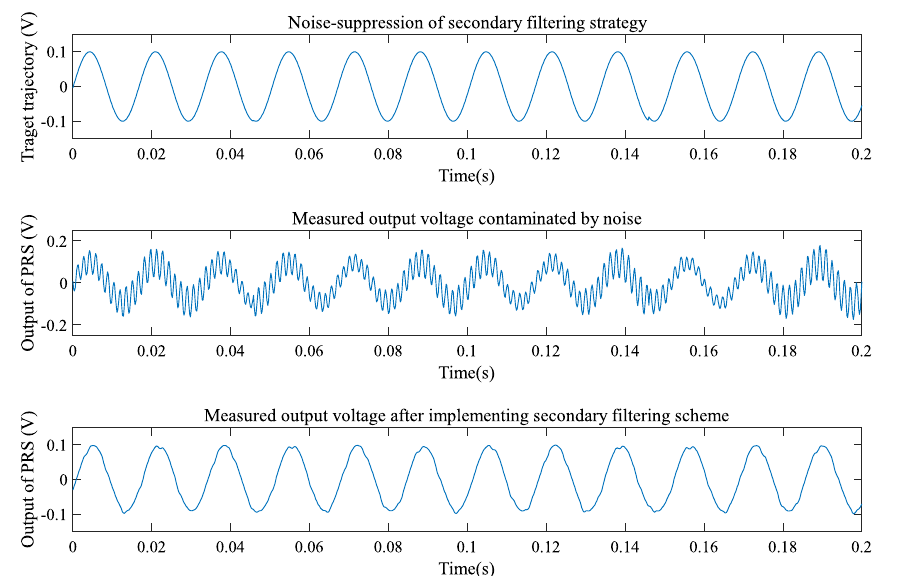
Figure 11. Noise suppression of the secondary filter in time-domain.